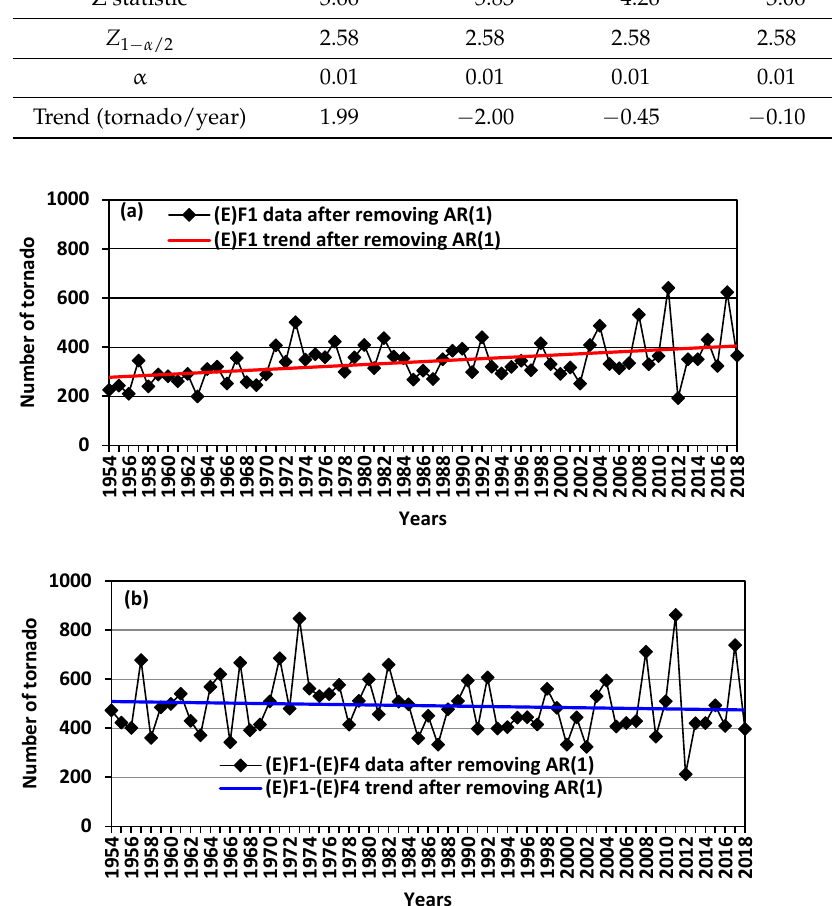
Figure 2. Time series of U.S. tornado counts (1954–2018) and its trend after removing AR(1) for.(a) (E)F1 tornado, and (b) sum of (E)F1 to (E)F4 tornado.